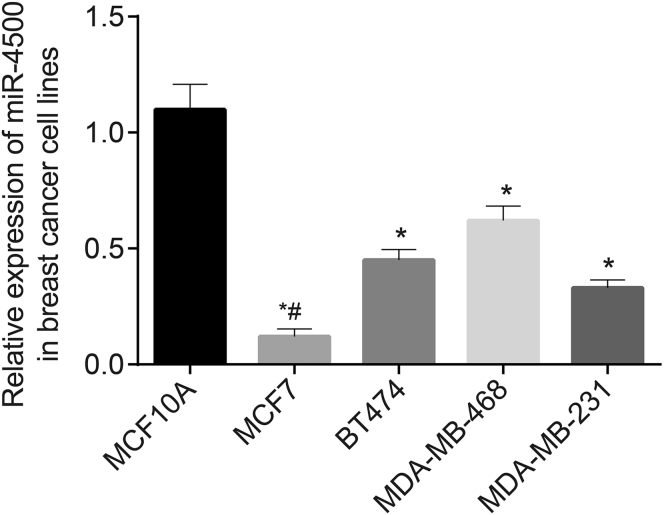
miR-4500 Is Poorly Expressed in Breast Cancer Cell Lines*p < 0.05 versus normal breast epithelial cell line MCF10A; #p < 0.01 versus breast cancer cell line MCF7. Data were analyzed by one-way ANOVA, and the experiment was repeated three times independently.